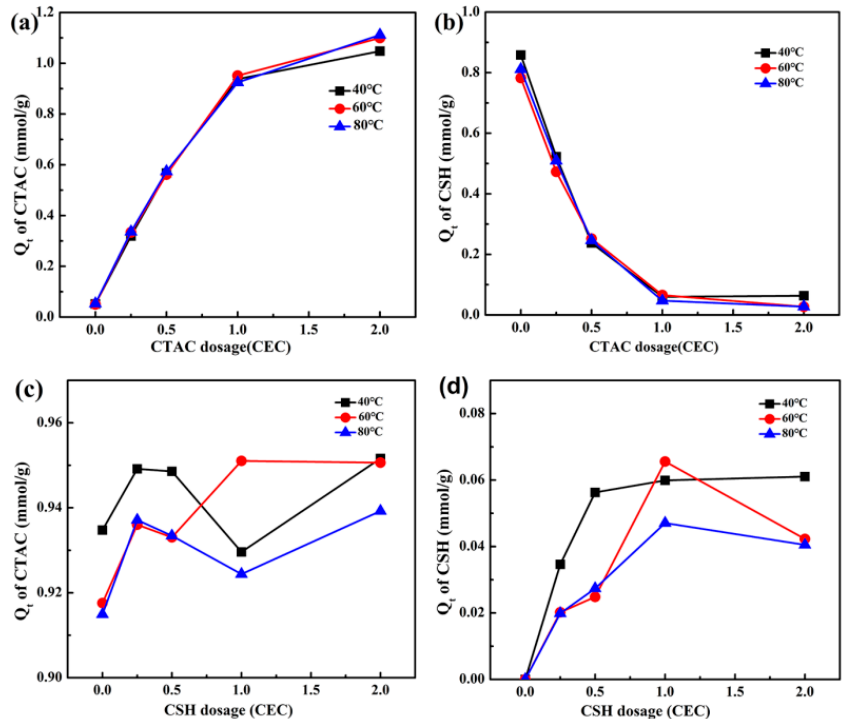
Figure 2. Effect of modification temperature on the adsorption amount ( Q t ) of cetyltrimethylammonium chloride (CTAC) ( a , b ) and cysteamine hydrochloride (CSH) ( c , d ) under the condition of different dosages of modifiers.